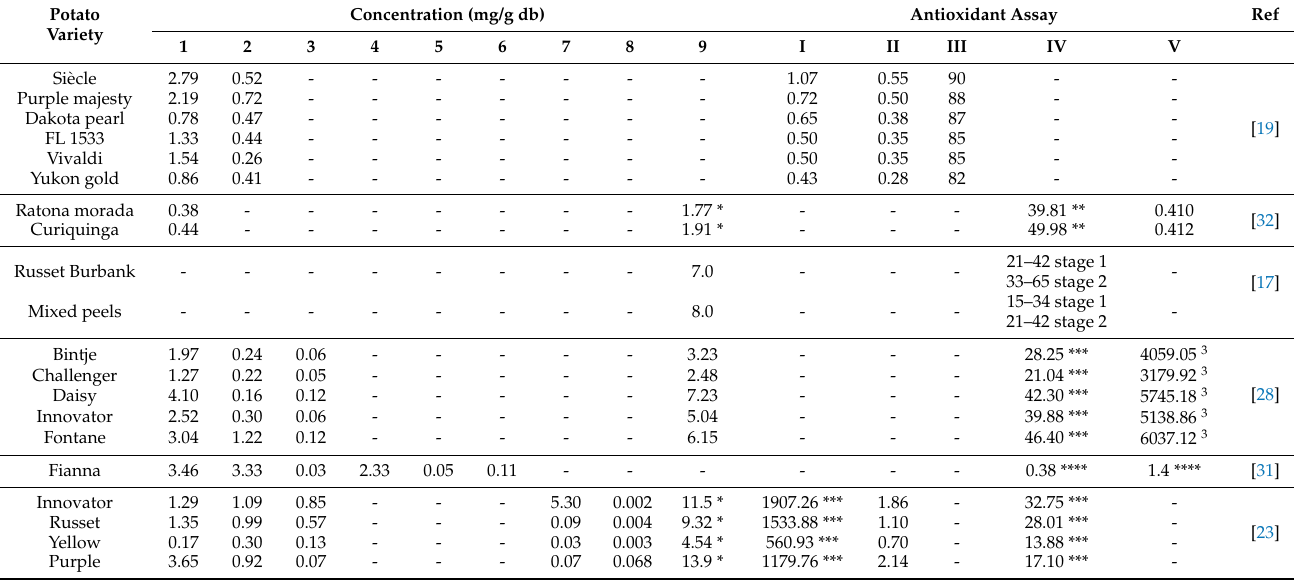
Table 1. Total phenolic content and the main phenolic compounds detected in different potato peel varieties. Potato